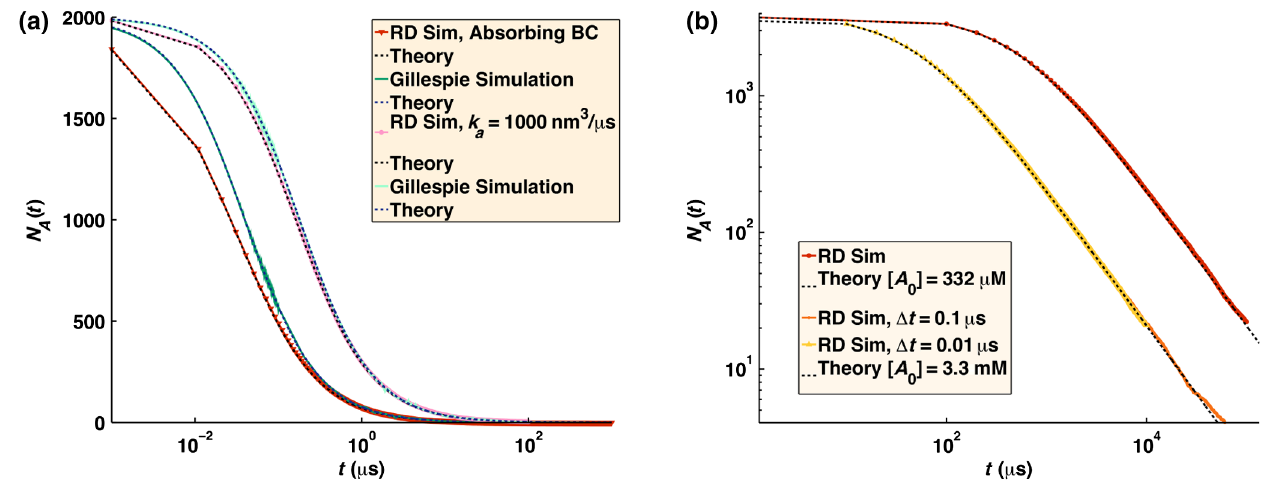
FIG. 8. Irreversible reaction A þ A → 0 . A ð t Þ versus time for (a) absorbing BC, Δ t ¼ 0 . 001 μ s and D AB ¼ 200 nm 2 = μ s. RD simulations are shown in red for a 16.6 mM concentration of A particles. The solution to Eq. (27), A ð t Þ ¼ fð 1 =A 0 Þþ ffiffi ffiffiffiffiffiffiffiffiffiffiffi p p t þ ð 2 σ t = D π k Þ(cid:4)g − 1 , is plotted in black dashed lines. In pink, we show RD simulations for k a ¼ 1000 nm 3 = μ s, D ½ tot 100 nm 2 = μ s, and given by A ð t Þ ¼ fð 1 =A Δ t ¼ 0 . 001 μ s, and D ffiffiffiffiffi AB ¼ ffiffi p p λπ k = ð k k k =k λ Þ þ k k = ð k k t þ ð k 2 t =k k Þ þ ð k a =k D λ Þ exp ð λ t Þ erfc ð D ½ a a þ D Þ(cid:4)ð a D D ½ a a þ D Þ(cid:4)½ a D son, we show results from Gillespie simulations for simple chemical kinetics (cyan, no symbols) of both reactions and the corresponding solution to Eq. (27) with the steady-state rate in blue dashed lines. (b) RD simulations with k a ¼ 10 nm 3 = μ s, Δ t ¼ 0 . 1 μ s, 20 nm 2 = μ s demonstrating the long-time steady-state decay at 332 μ M concentration of A particles (red Δ t ¼ 0 . 01 μ s, and D AB ¼ circles) and 3.3 mM (orange and yellow data simulated with different time